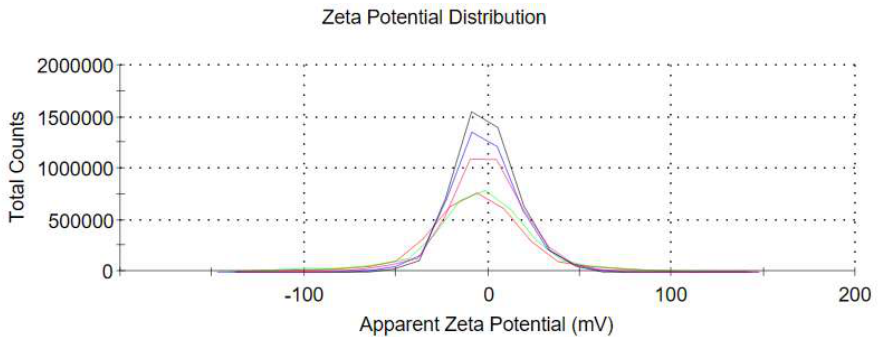
Figure 2. Zeta potential of 40 nm PS spheres in N , N -dimethylformamide (DMF) at room temperature.